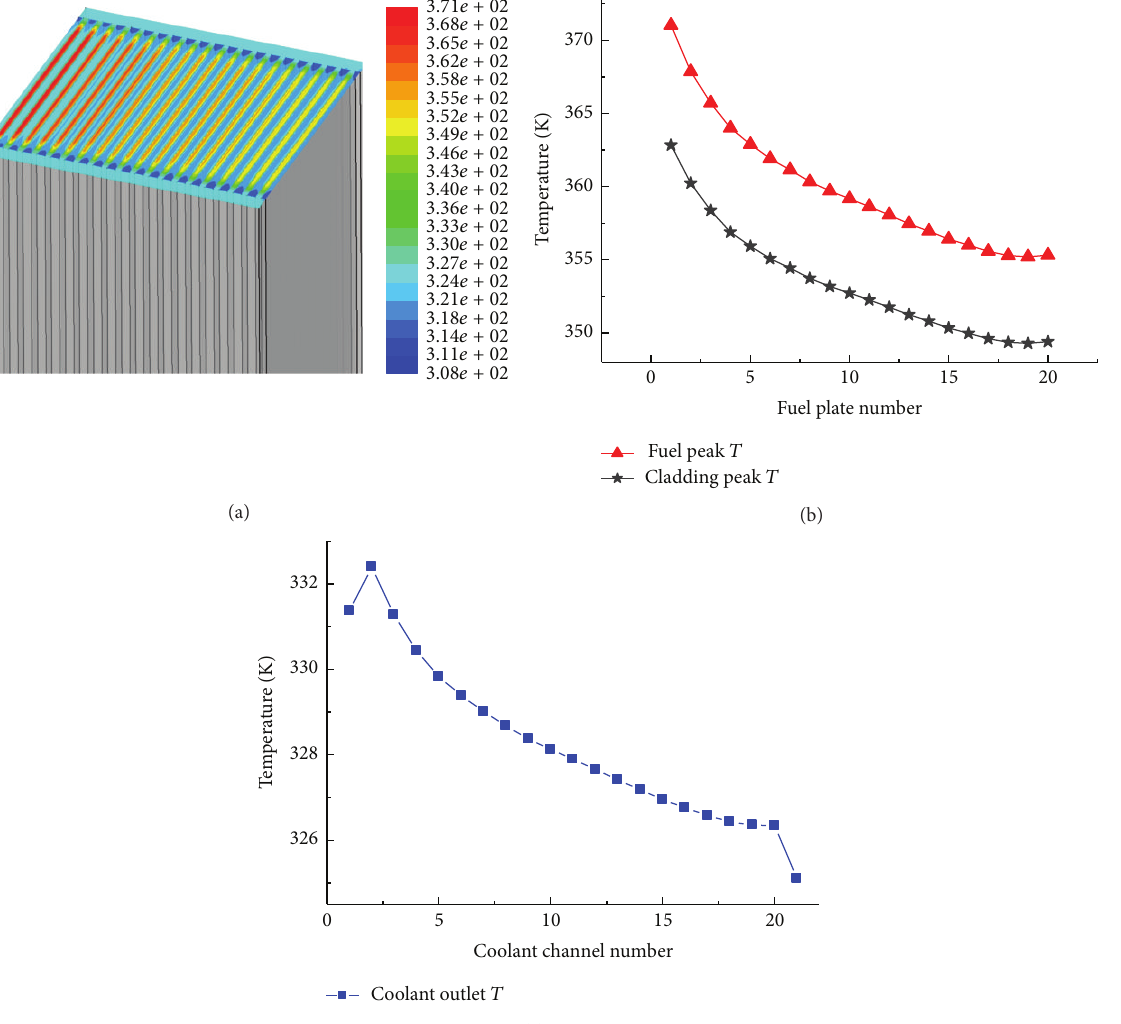
Figure 17: Calculation results in the hot assembly (average inlet velocity: 4.5